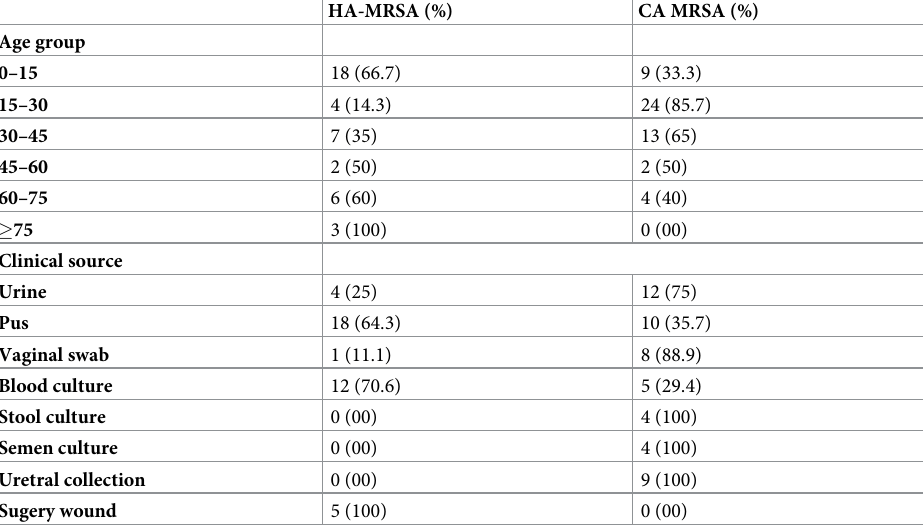
Table 2. Repartition of MRSA based on age group and clinical